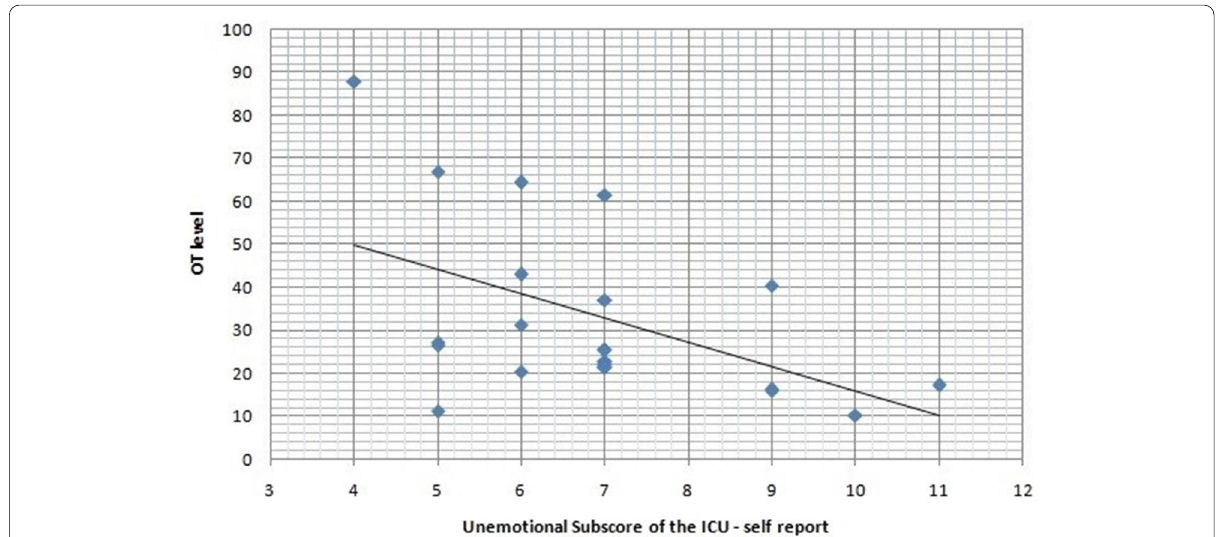
Fig. 5 Correlation between oxytocin levels and the unemotional subscore of the Inventory of Callous-Unemotional Traits (ICU—self -